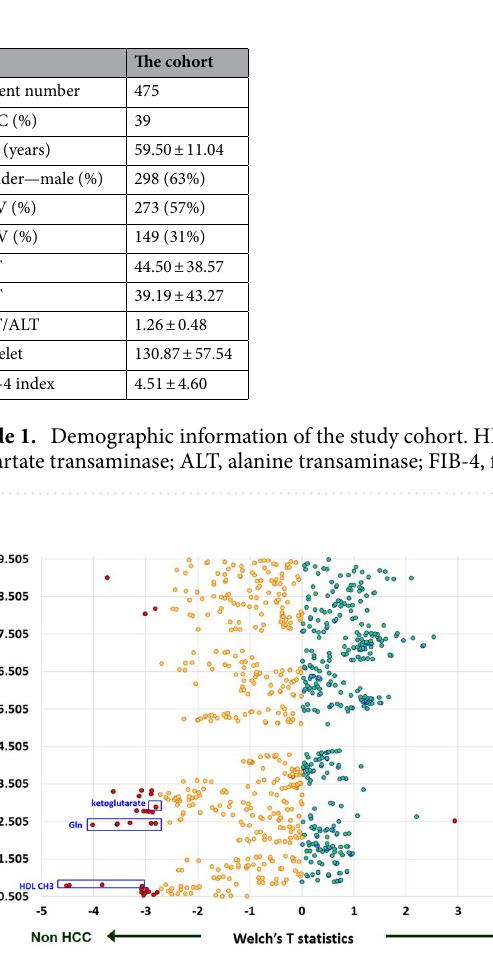
Figure 1. Metabolomic profiling of the cohort of liver cirrhosis patients. The vertical axis indicated the 1 H nuclear magnetic resonance chemical shifts (between 0.505 and 9.495 ppm). The horizontal axis indicated Welsh’s t-statistics in the comparison of patients with or without the occurrence of HCC during follow-ups. Cyan and yellow dots represent positive or negative associations with HCC. Those with significant association (P ≤ 0.01) were particularly highlighted as red dots.